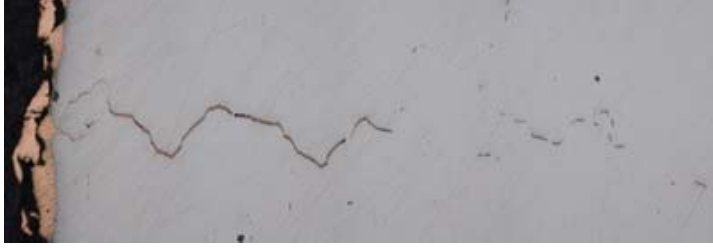
Figure 2. Copper infiltration into a S345J steel matrix.